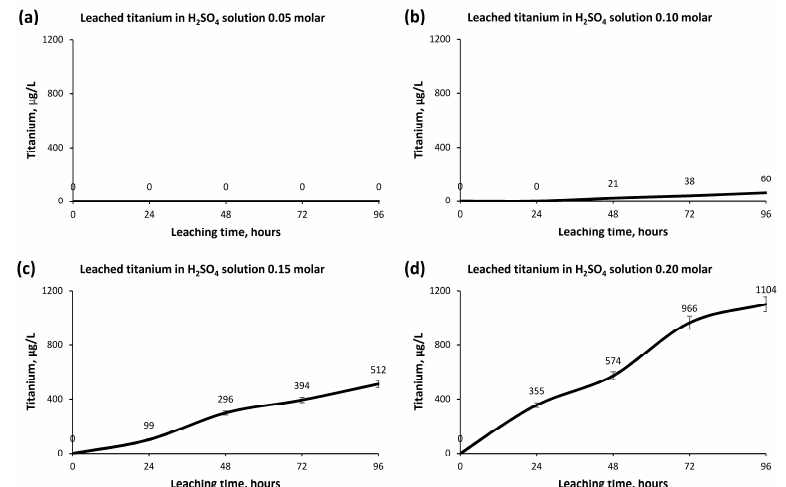
Figure 11. Analysis of the Titanium concentration in the leaching process at atmospheric pressure, ambient temperature and in different Sulphuric Acid solutions: ( a ) 0.05 molar H 2 SO 4 solution, ( b ) 0.10 molar H 2 SO 4 solution, ( c ) 0.15 molar H 2 SO 4 solution and ( d ) 0.20 molar H 2 SO 4 solution. Titanium, as reflected by the x-ray fluorescence test, represents a very low percentage in the mining waste sample and its extraction is not interesting. However, it shows a very interesting behavior to determine by comparison the quality of the Copper leaching process. Unlike the results obtained from the Copper concentrations, the concentrations in the Titanium solutions perfectly show the inactivity of the 0.05 and 0.10 molar Sulphuric Acid solutions. The solutions with molarities 0.15 and 0.20 reflect, on the other hand, the beginning of activity, showing an upward trend without reaching the stabilization in the time and an important difference between the concentrations of the last two solutions. This fact reflects the inadequacy of this leaching process for Titanium, which is not in the scope of the study, and the notable difference with the Copper recovery process is, therefore, determined objectively by the quality of the leaching process for copper recovery from mining waste. Finally, Figure 12 shows the concentrations of Arsenic in the different solutions and in the different leaching times.